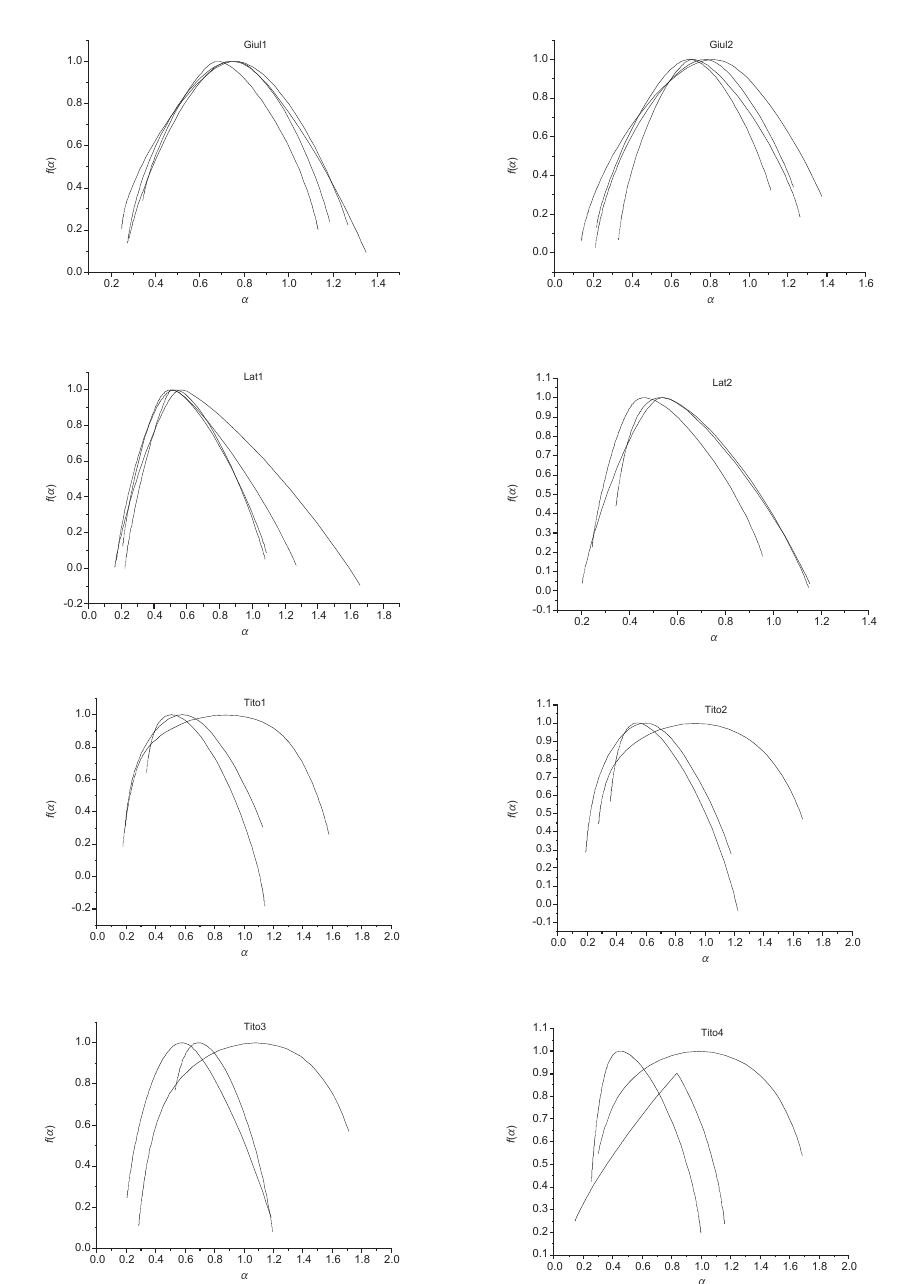
Fig. 3. Legendre spectra of the signals measured in Southern Italy. For each signal, we selected the 3-4 longest segments without gaps, whose order of magnitude of length is 10 3 . All the spectra show a single-humped shape, typical of multifractal